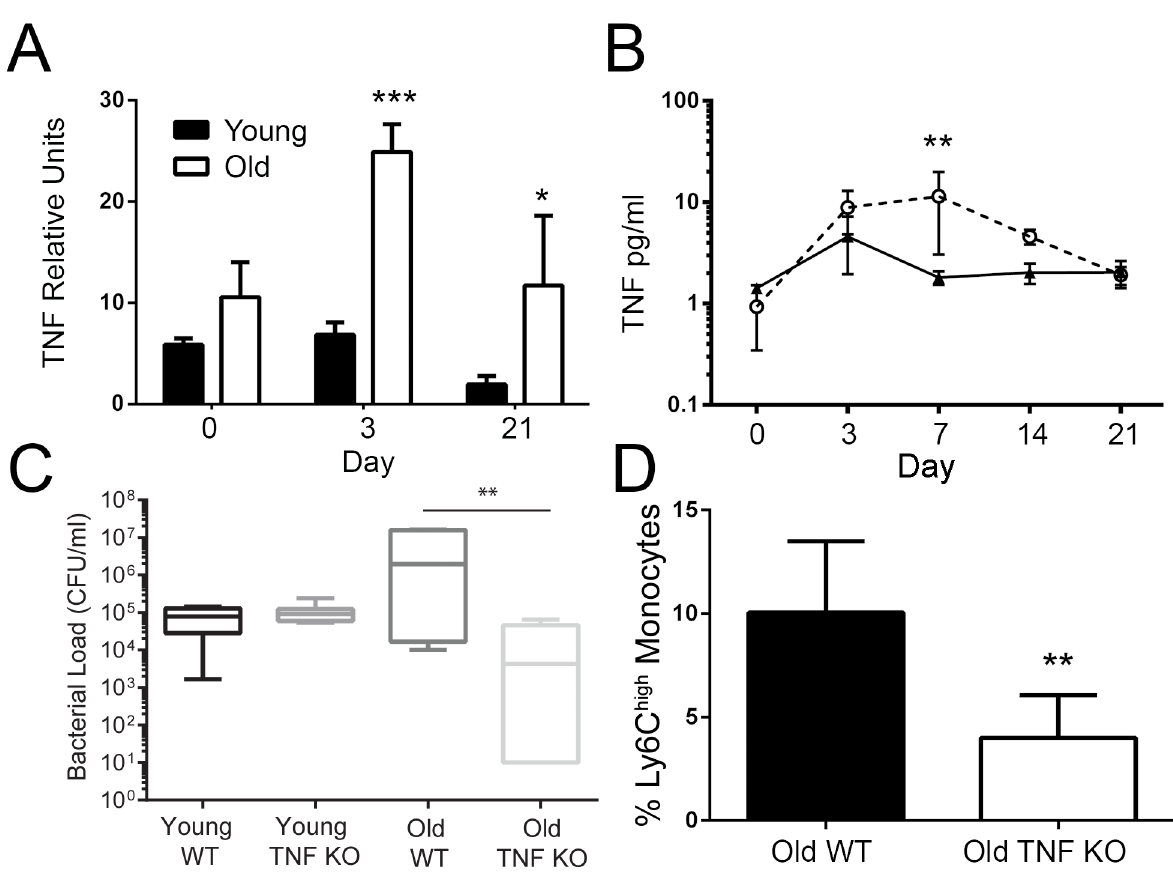
Fig 7. Reducing TNF-regulated recruitment of Ly6C high monocytes during S . pneumoniae colonization in old mice reduced nasopharyngeal bacterial loads. (A-B) TNF in the (A) nasopharnyx and (B) serum of young and old mice during S . pneumoniae colonization as measured by qPCR and ELISA, respectively ( ± SEM; n = 3 – 5). (C) CFUs in nasal lavages of old WT and old TNF mice on day 4 after colonization with S . pneumoniae ( ± SEM; n = 6 – 8, one independent experiment of two shown). (D) Ly6C high monocytes as a percent of circulating CD45+ cells in old WT and TNF KO mice on day 4 of S . pneumoniae colonization ( ± SEM; n = 3 – 4, one independent experiment of two shown). Statistical significance was determined by two-tailed Mann- Whitney-Wilcoxon test, one-way ANOVA or two-way ANOVA with Fisher's LSD post-test where appropriate. * indicates p < .05, ** indicates p < 0.005, *** indicates p < 0.0005 and **** indicates p <